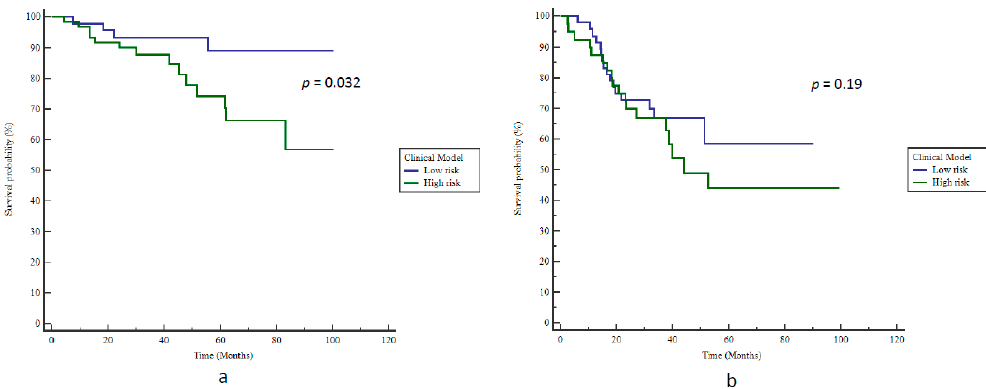
Figure 3. Kaplan–Meier estimates of biochemical relapse-free survival using the clinical model for ( a ) training and ( b ) testing cohorts. Cancers 2020 , 12 , x